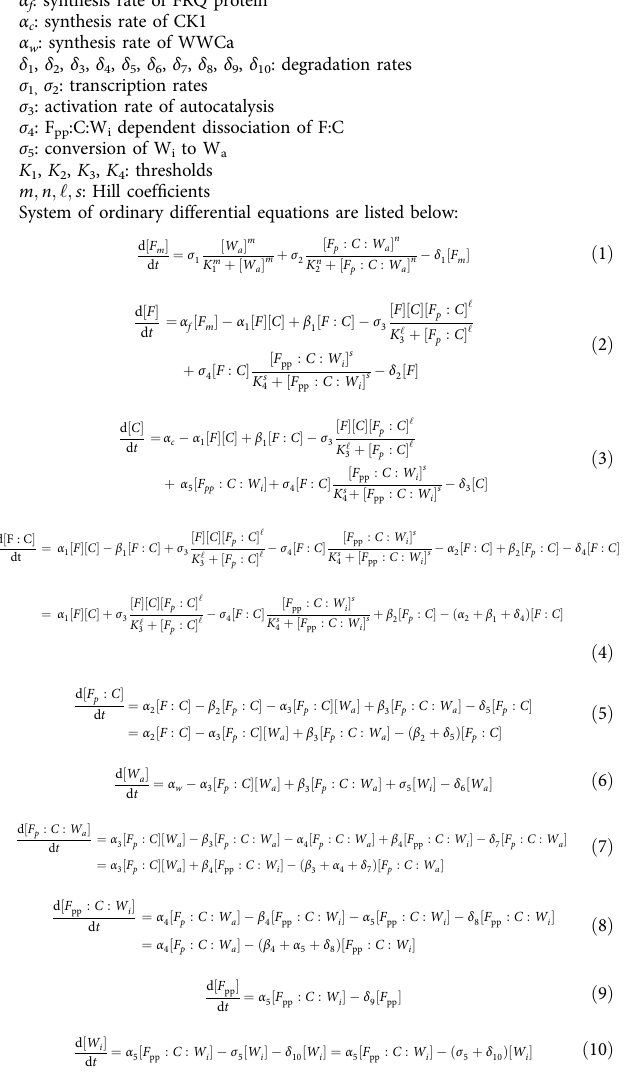
RNA was extracted with Trizol (Ambion, Cat#15596018) in accordance with the manufacturer ’ s protocol, and then further puri fi ed with 2.5 M LiCl (Sigma- Aldrich, L4408-500G) 67 . For northern blot analyses, equal amounts of total RNA (20 μ g) were loaded onto agarose gels. After electrophoresis, the RNA was transferred onto nitrocellulose membrane (GVS North America, Cat#1212590). The membrane was probed with [ 32 P] UTP (PerkinElmer, Cat#BLU007H250UC) -labeled RNA probes speci fi c for frq 5 ′ UTR. RNA probes were transcribed in vitro from PCR products by T7 RNA polymerase (Ambion) as per the manufacturer ’ s protocol. The frq primer sequences used for the template ampli fi cation were frq Northern F, 5 ′ -TAATACGACTCACTATAGGGGAAGCCTGCGATGCTACTC AC-3 ′ , and frq Northern R, 5 ′ -CATCGCATCCACTTCGCACAC-3 ′ . The list of primers used in this study is shown in Supplementary Table 3. Immunoprecipitation and FLAG pull-down analyses . IP analyses were per- formed as previously described 51 . Brie fl y, Neurospora proteins were extracted as described above. For each immunoprecipitation reaction, 2 mg protein and 1.5 μ L c-Myc antibody (Roche, Cat#11667203001), 1 μ L WC-2 antibody 43 , or 1 μ L CK1a antibody were used. After incubation with antibody for 3 h, 40 μ L Gam- maBind G Sepharose beads (GE Healthcare) were added, and samples were incubated for 1 h. For the FLAG pull-down assay, 4 mg puri fi ed FLAG-CK1a fusion protein and 2 μ L FLAG antibody (Sigma-Aldrich, Cat#F1804) were incubated with 2 mg Neurospora extracts. After incubation with antibody for 3 h, 40 protein GammaBind G Sepharose beads were added, and samples were incubated for 1 h. Immunoprecipitated proteins were washed three times using extraction buffer before Western blot analysis. IP experiments were performed using cultures harvested in constant light (LL) except for the rhythmic experi- ments. Quanti fi cation of relative FRQ-CK1a or FRQ-WC-2 interaction levels are based on the ratio of IP to Input and normalized with CK1a or WC-2 levels, respectively. Protein stability assays . For CHX (Sigma-Aldrich, Cat#C7698-5G) treatments, discs made from 2-day-old mycelial mats of individual strains were grown in liquid media for 1 day under constant light conditions. CHX was then added to a fi nal concentration of 10 μ g/mL, and tissues were harvested at the indicated time points. Trypsin digestion assays . For the trypsin-sensitivity assay, protein extracts were diluted to a protein concentration of 2.5 μ g/ μ L. A 100- μ L aliquot was treated with trypsin ( fi nal concentration 1 μ g/mL) at 25 °C. A 20 μ L sample was taken from the reaction at each time point (0, 5, 15, and 30 min) after addition of trypsin. Protein samples were mixed with protein loading buffer and resolved by SDS-PAGE. To compare trypsin sensitivity of FRQ from different strains, experiments were per- formed side by side, and the protein samples were transferred to the same mem- brane for western blot analysis. ChIP analyses . ChIP assays were performed as previously described 48,68 . Brie fl y, Neurospora tissues were fi xed with 1% formaldehyde for 15 min at room tem- perature with shaking. Glycine was then added at a fi nal concentration of 125 mM. The cross-linked tissues were ground and resuspended in lysis buffer (50 mM HEPES, pH 7.5, 137mM NaCl, 1mM EDTA, 1% Triton X-100, 0.1% deoxycholate, 0.1% SDS). Chromatin was sheared using sonication to 500 – 1000 base-pair frag- ments. For each immunoprecipitation reaction, 1mg protein was used. WC-2 antibody was generated previously 43 . The ChIP reaction was carried out with 2 μ L WC-2 antibody. Immunoprecipitated DNA was enriched using GammaBind G Sepharose beads and washed sequentially with low-salt washing buffer (0.1% SDS, 1% Triton X-100, 2mM EDTA, 150 mM NaCl, 20 mM Tris – HCl, pH 8), high-salt washing buffer (0.1% SDS, 1% Triton X-100, 2mM EDTA, 500mM NaCl, 20mM Tris – HCl, pH 8), LNDET buffer (0.25 M LiCl, 1% NP40, 0.1% deoxycholate, 1 mM EDTA,10mM Tris – HCl, pH 8), and TE buffer (1 mM EDTA, 10mM Tris – HCl, pH 8). Elution buffer (1% SDS, 0.1M NaHCO3) was used to retrieve protein-DNA complex. Finally, eluted DNA was puri fi ed and quanti fi ed by real-time qPCR. The primer sets used were frq C-box F, 5 ′ -GTCAAGCTCGTACCCACATC-3 ′ , and frq C-box R, 5 ′ -CCGAAAGTATCTTGAGCCTCC-3 ′ . Occupancies were normalized by the ratio of ChIP to Input DNA. Generation of CK1a antibody . The GST-CK1a fusion protein (containing CK1a amino acids Q299-E384) was expressed in BL21 cells, and the recombinant pro- teins were puri fi ed and used as the antigens to generate rabbit polyclonal antisera 69 . Quanti fi cation and statistical analyses . Quanti fi cation of western blot and northern blot data were performed using Image J software. All studies were per- formed at least three independent experiments (different days and different pre- parations). Error bars are standard deviations for IP assays and standard error of means for race tube assays. Statistical signi fi cance was determined by Student ’ s t - test. Mathematical model . Variables used